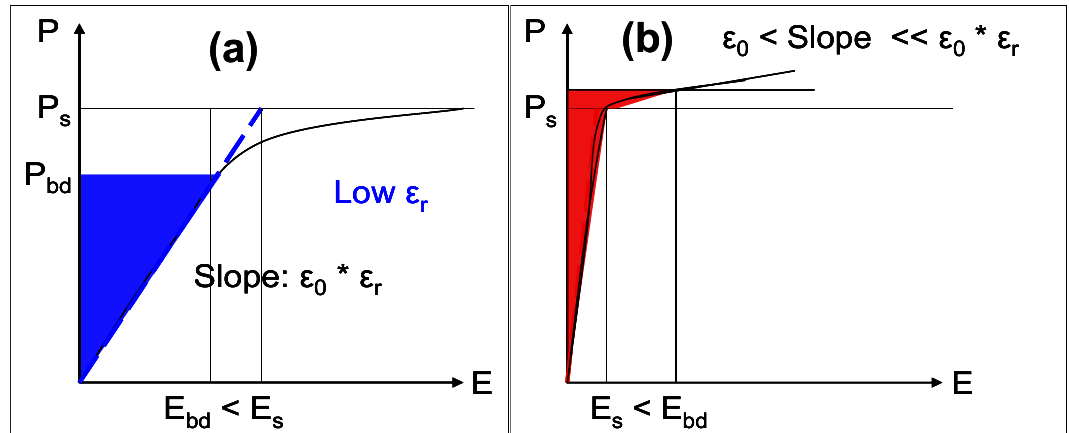
< E ); ( b ) As for ( a ) but bd s < E s bd